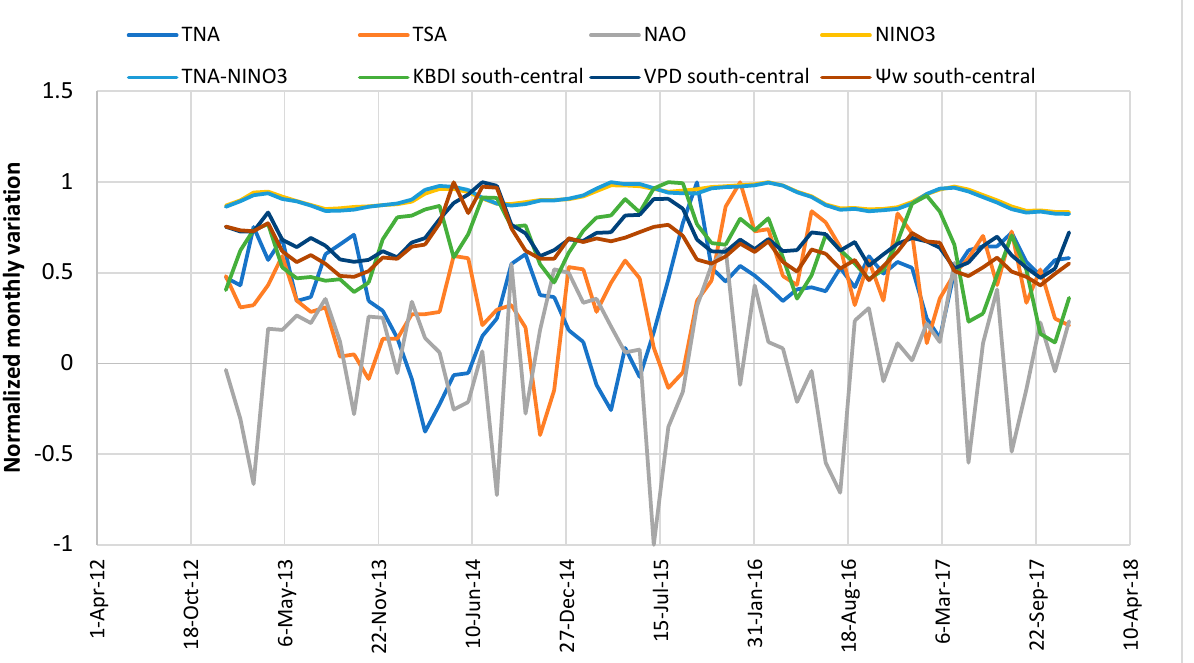
Table 6. Correlations between bushfire potential indices (KBDI, VPD and Ψ w ) for south-central Ja- maica and indices representing large-scale atmospheric and oceanic patterns. Correlations calcu- lated for monthly timeseries over 2013–2017 with zero and 1-month lag.